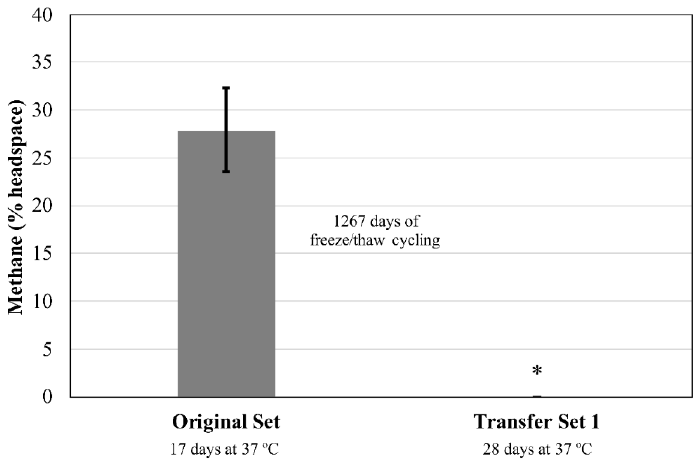
Figure 7. Methane production by Methanobacterium formicicum following an initial incubation period for each of two sets. Original Set test tubes contained 5 mL MSF medium. Transfer Set 1 test tubes contained 10 mL MSF medium. Transfer Set 1 tubes ( n = 5) were inoculated from the corresponding replicate in the Original Set ( n = 5) following 1284 days of freeze/thaw cycles (Table 5). The asterisk indicates that no methane was detected. Error bars indicate one standard deviation.